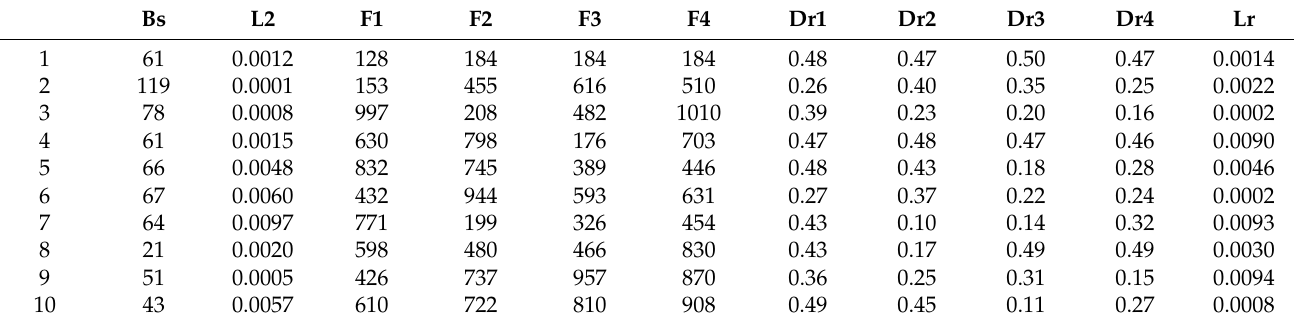
Table 15. Positions of individuals of SSA in the experiment on Five